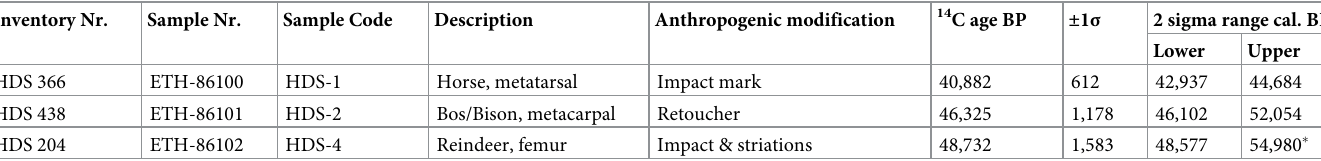
Legend: Calendar age 2 σ range cal. BP-calibrated ranges. Calibrated with IntCal20 and Calib Rev 8.1.0 [126]. � Date most likely meets the end of the calibration data